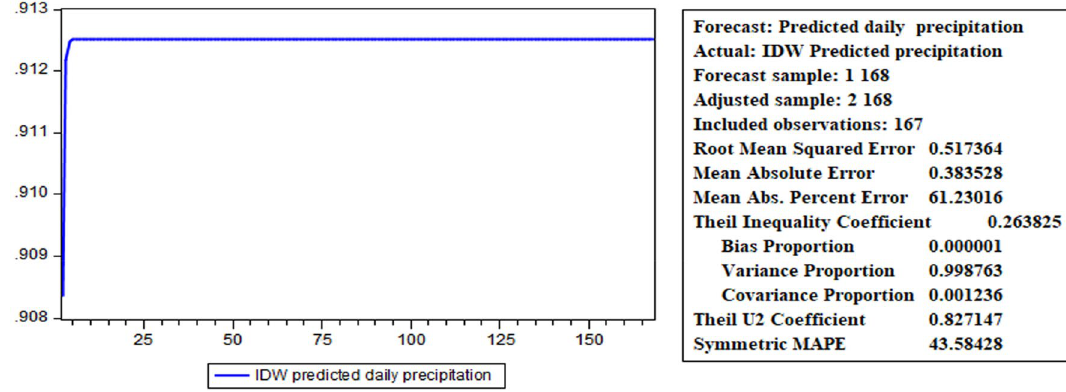
Fig. 4 The daily rainfall probabilities based on the IDW